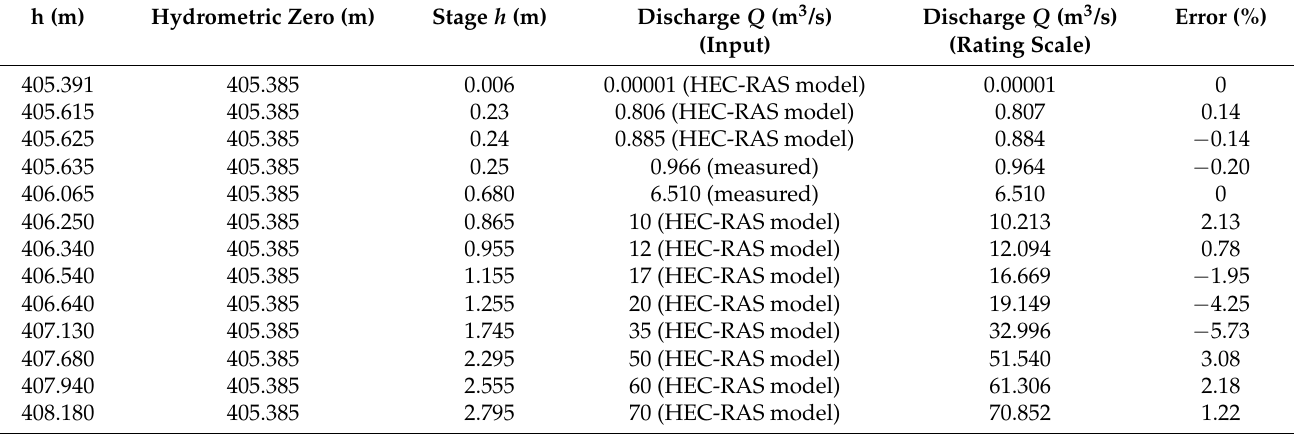
read (Table 2). Table 2. Pontelatrave station on the Chienti River, section 2. HEC-RAS model: steady flow analysis, mixed flow regime, boundary conditions (upstream condition: slope of the water surface or bottom = roughness coefficient (riverbed = 0.048, floodplains =